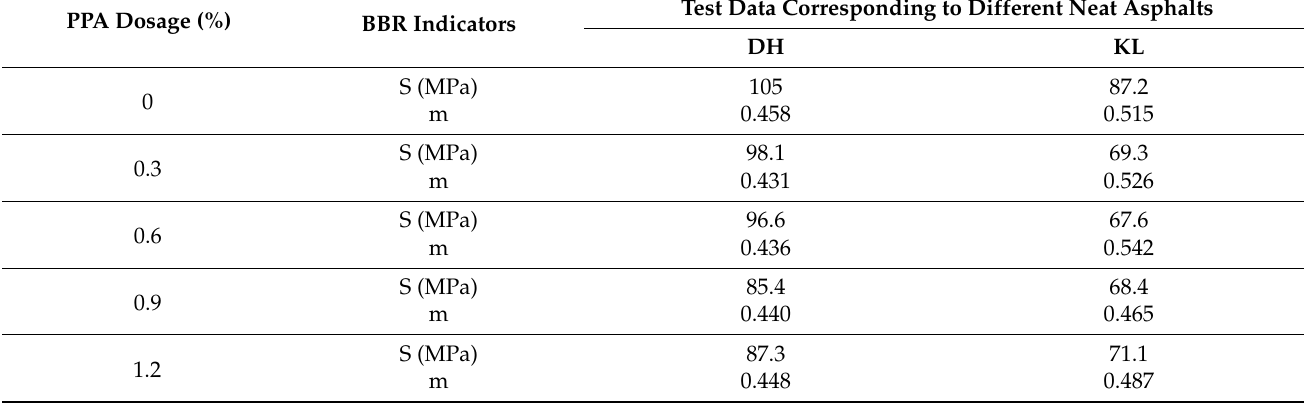
Table 4. BBR test results of PPA-modified asphalt.